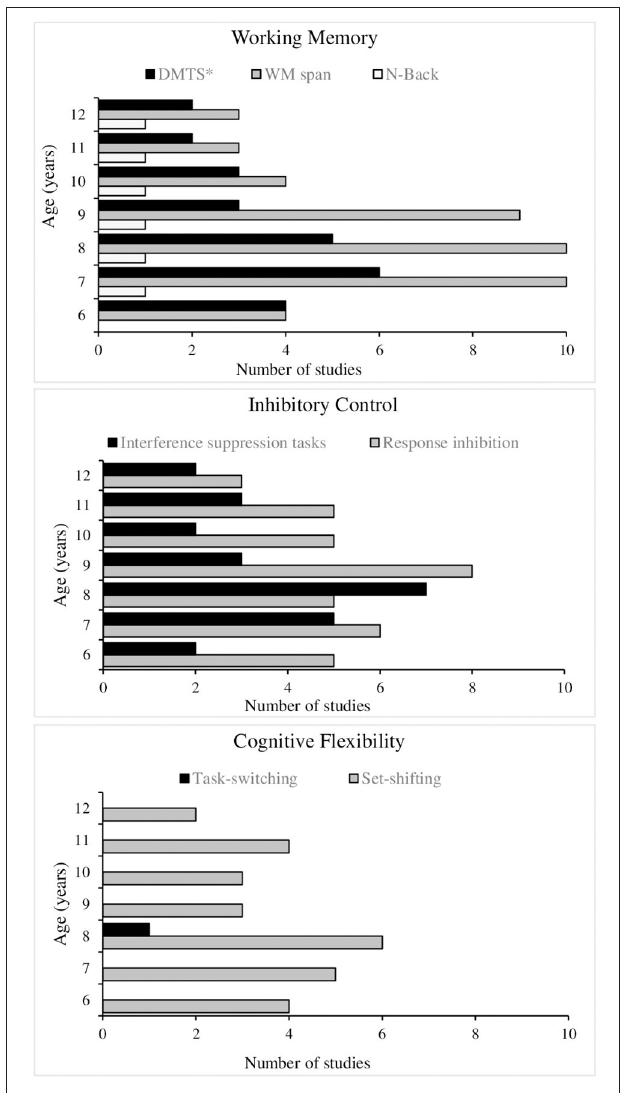
FIGURE 4 | Frequency of task type used to evaluate cool EFs in reviewed studies, by age group.